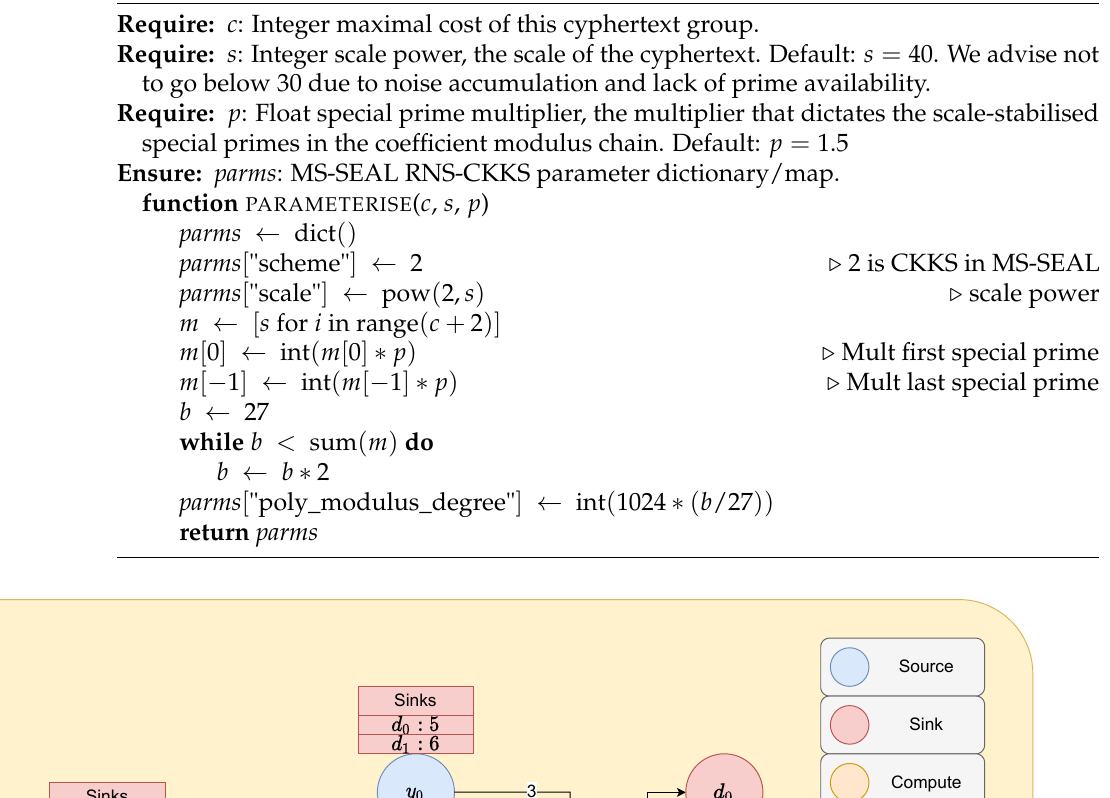
Algorithm 8 Heuristicallyparameterise RNS-CKKS scheme using expected cost of computation.